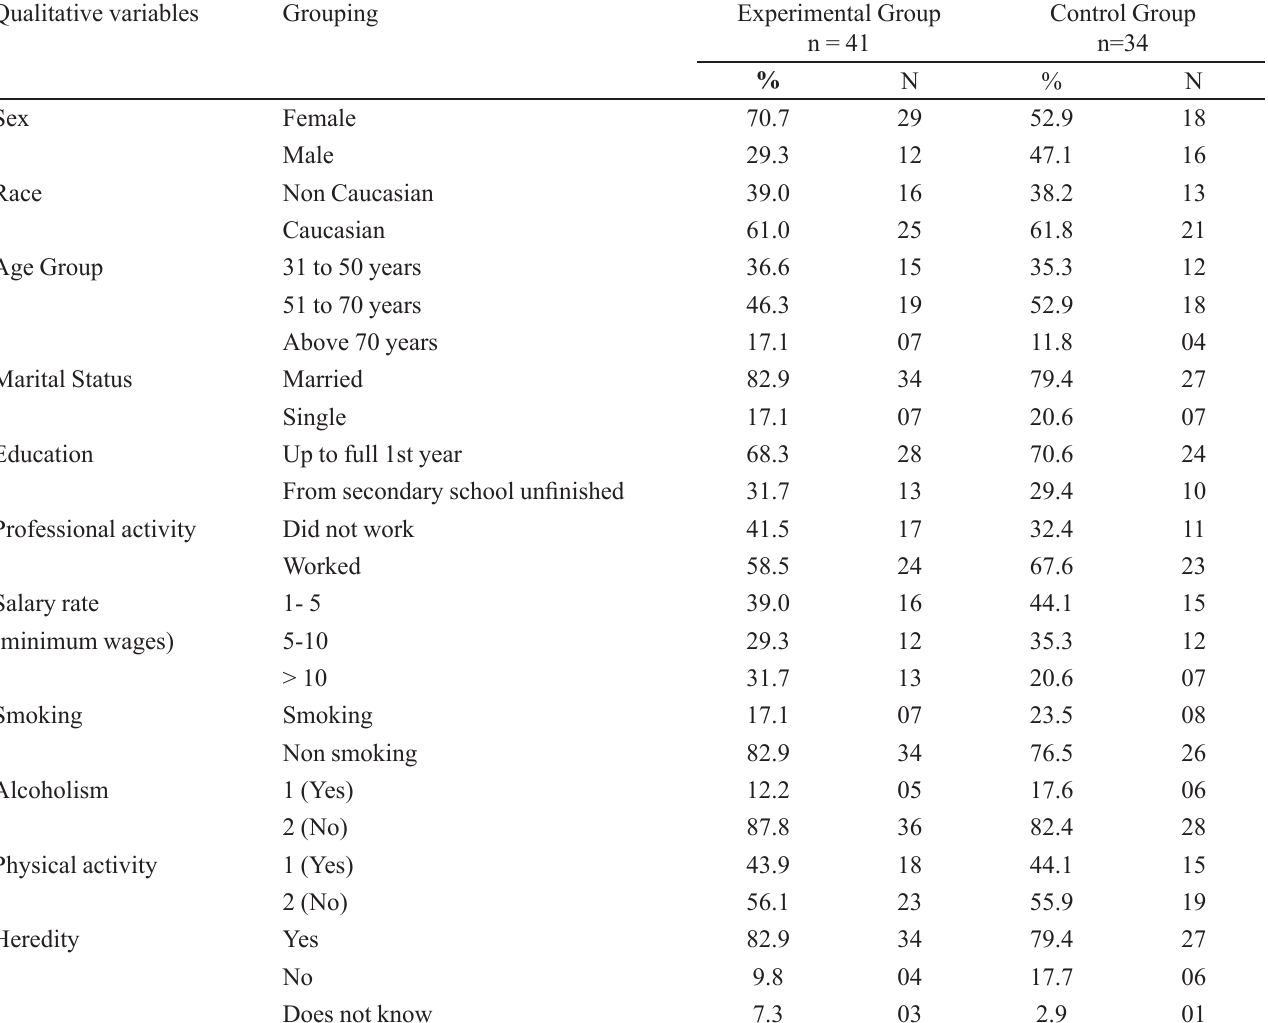
TABLE I - Profile of experimental and control group total populations Qualitative variables